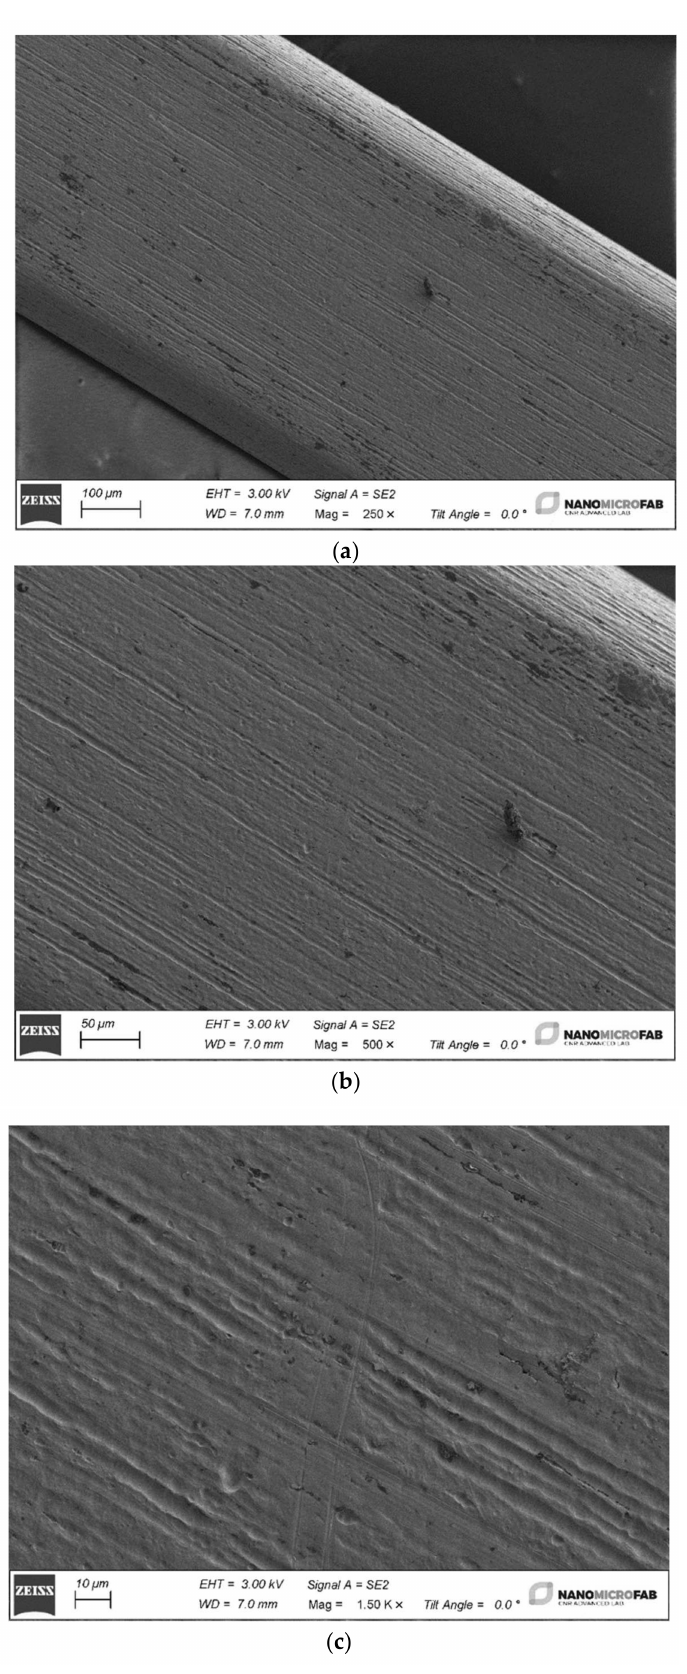
Figure 2. Three images of a Ni–Ti archwire sample captured at increasing magnification: ( a ) image at 250 × ; ( b ) image at 500 × ; ( c ) image at 1500 ×